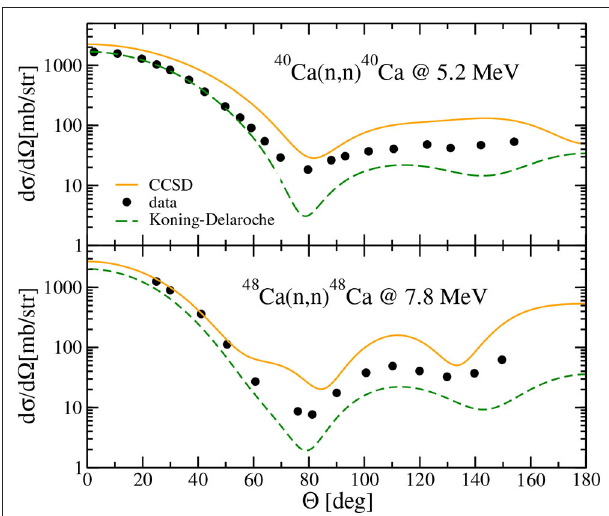
FIGURE 3 | Differential elastic cross section for 40 Ca(n,n) 40 Ca at 5.2 MeV (top) and 48 Ca(n,n) 48 Ca at 7.8 MeV (bottom) calculated with the NNLO sat interaction. Results obtained with the phenomenological Koning-Delaroche potential potential are shown (dashed line) for comparison. Data points are taken from Koning and Delaroche[ 36] (errors on the data are smaller than the